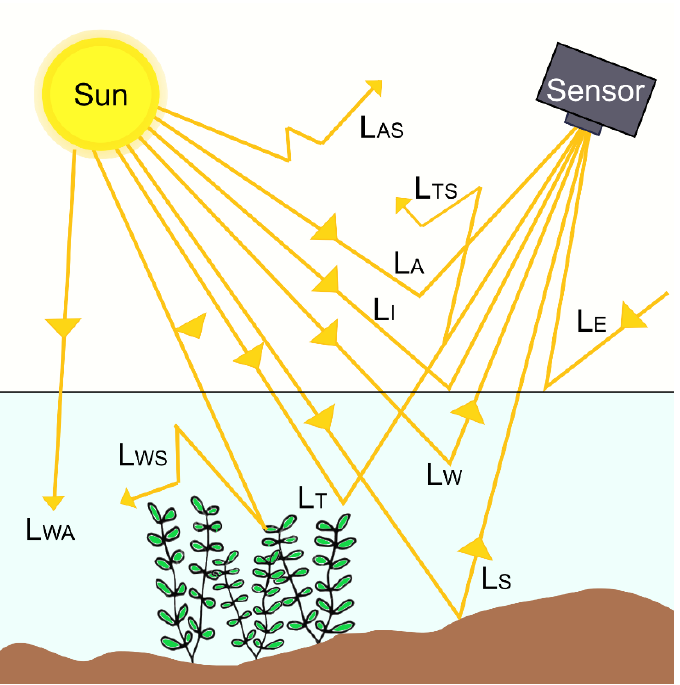
Figure 3. A simplified illustration of the interactions of light as they originate from the sun and are recorded by an optical sensor. The labels are as follows: L T = Radiance reflected by the target; L TS = Radiance reflected by the target then scattered out of the path to the sensor; L S = Radiance reflected by the non-target substrate; L A = Radiance reflected by the atmosphere to the sensor (also referred to as path radiance); L AS = Radiance scattered by the atmosphere; L W = Radiance reflected by the water column into the sensor; L WS = Radiance scattered by the water column; L WA = Radiance absorbed by the water column; L I = Radiance reflected by the air-water interface; L E = Radiance that is scattered into the scene by the ambient environment.